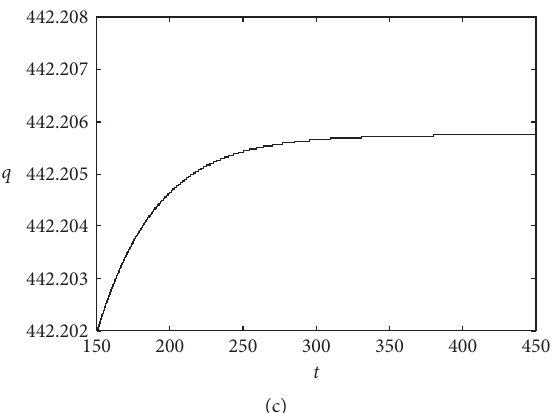
Figure 7: The stable positive equilibrium in system (10), where the phase portrait is displayed in (a) and time histories in (b) and